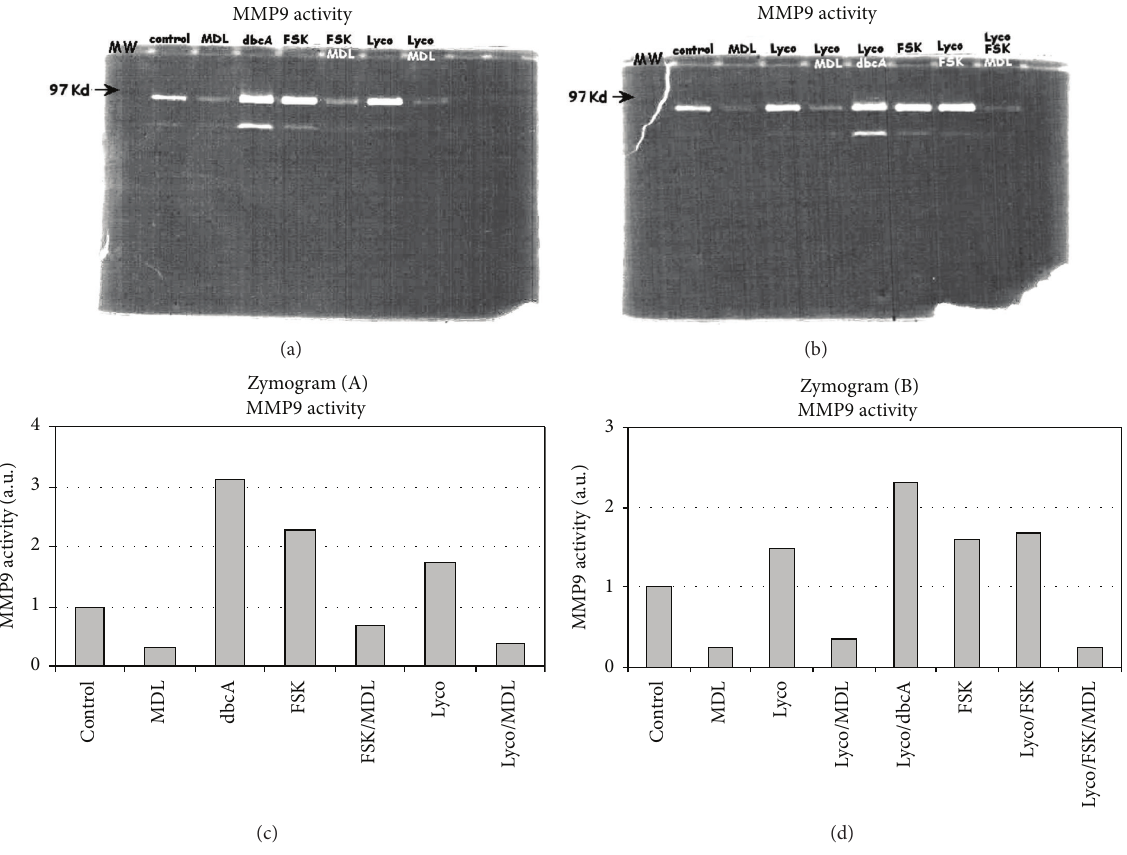
Figure 6: MMP9 activity is induced by lycopene in THP1 cells. THP1 cells were cultured for 12h in the presence or not of lycopene (2 𝜇 M) together with or without different effectors acting specifically on the c-AMP metabolism (FSK, MDL, and IBMX). Culture medium was collected and zymography ((a), (b)) was performed as described under Materials and Methods. Densitometry analysis of zymograms (A) and (B) was performed and results are reported on graphs (c) and (d), respectively. One representative experiment out of three is shown.